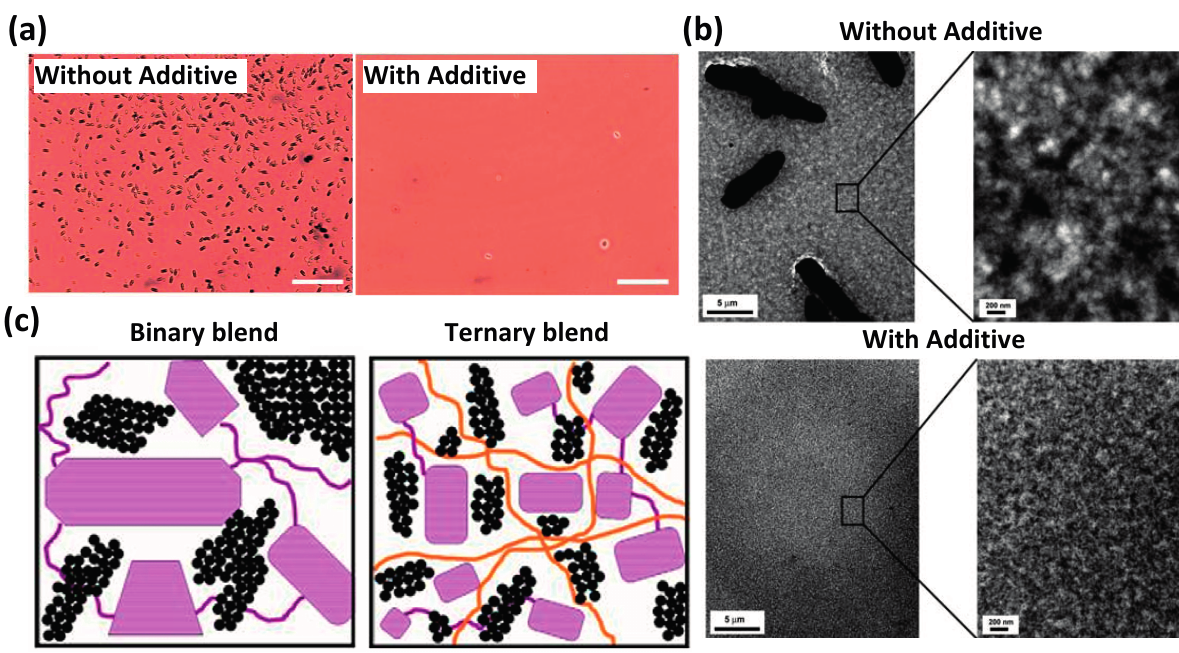
Figure 4. ( a ) Optical microscopy images of P3HT/PCBM BHJ without and with additives fullerene end-capped polyethylene glycol after thermal aging at 60 °C for 300 h; ( b ) TEM images of P3HT/PCBM BHJ without and with additives C 60 -end capped P3HT after thermal aging at 150 °C for 48 h; ( c ) Schematic illustrations of P3HT:regular/PCBM binary blend and P3HT:regular/P3HT:random/PCBM ternary blend. Reprinted with permission from [46,47] copyright 2011, 2010 Royal Society; [48] copyright 2012 Elsevier . Without Additive Without Additive With Additive